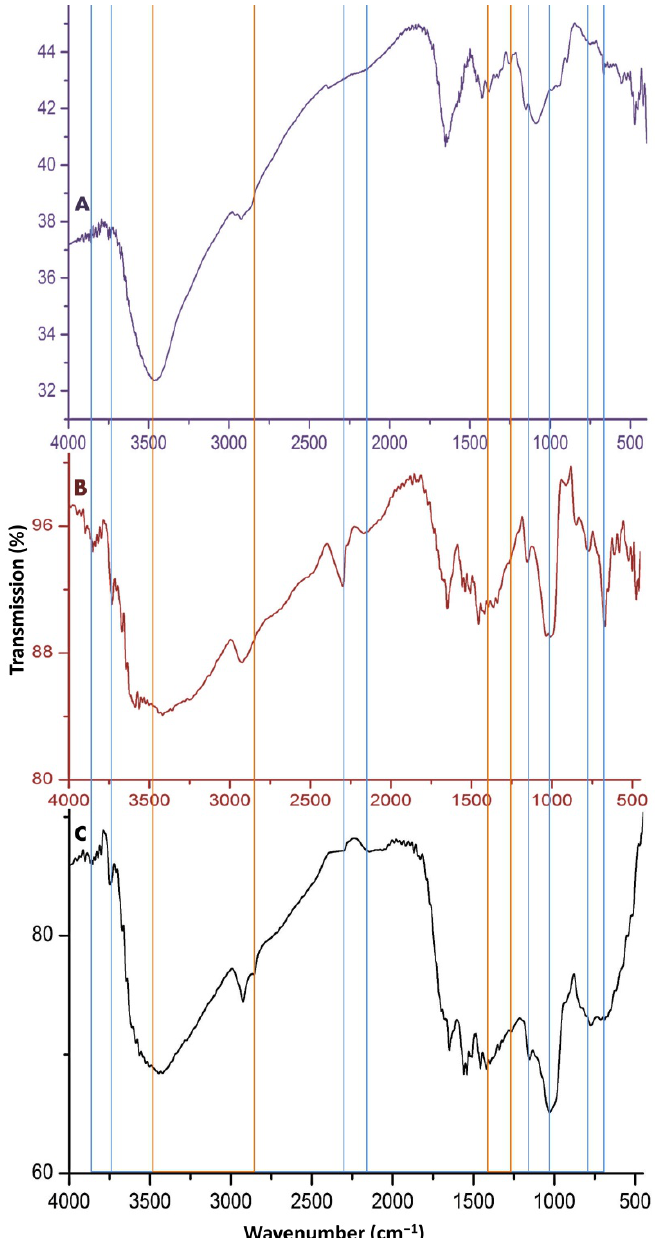
Figure 1. The infrared analysis (FTIR) of employed molecules in the current study, including ( A ) nanochitosan, ( B ) shilajit water extract and ( C ) their composites*. * The blue vertical lines indicate the derived bonds from SWE and the red lines indicate the derived bonds from NCT in the SWE/NCT spectrum.